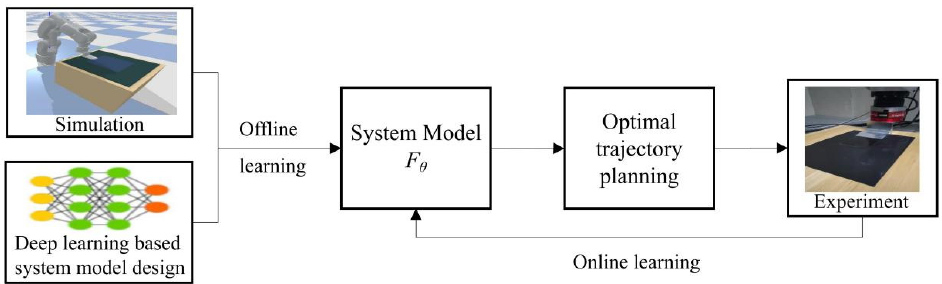
Figure 3. Manipulation planning framework for automated peeling of glass substrate.